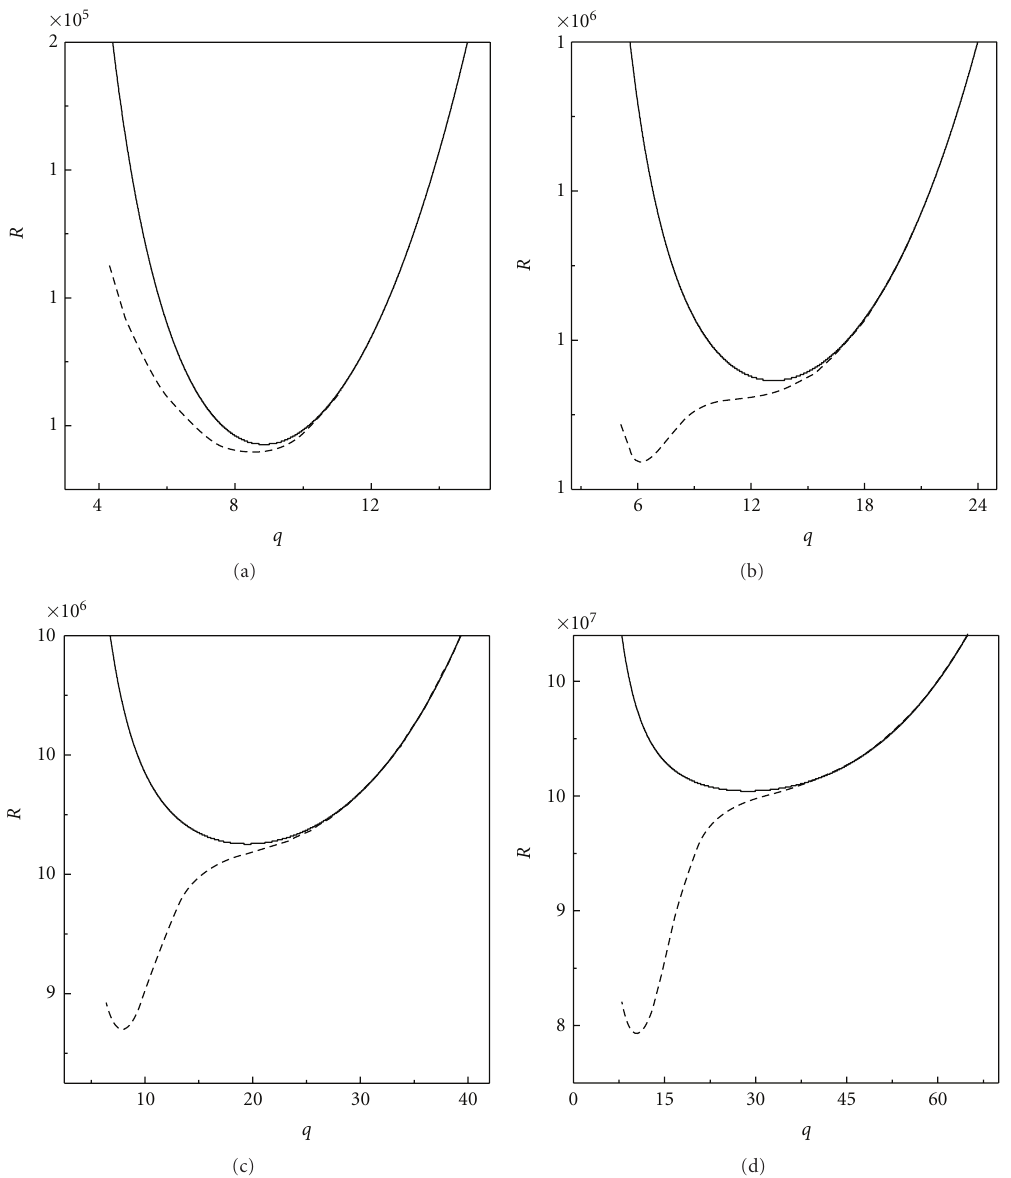
Figure 1: Numerically calculated marginal stability curves are plotted in ( R , q )-plane for Pr 1 = 1, Pr 2 = 1 . 5, D a = 1500, Λ = 0 . 85, φ = 0 . 9, and M = 0 . 9, (a) Q = 10 4 , (b) Q = 10 6 , (c) Q = 10 8 , and (d) Q = 10 10 , then the onset of stationary convection and the onset of oscillatory convection increase (stationary convection represented by solid lines and oscillatory convection represented by dotted